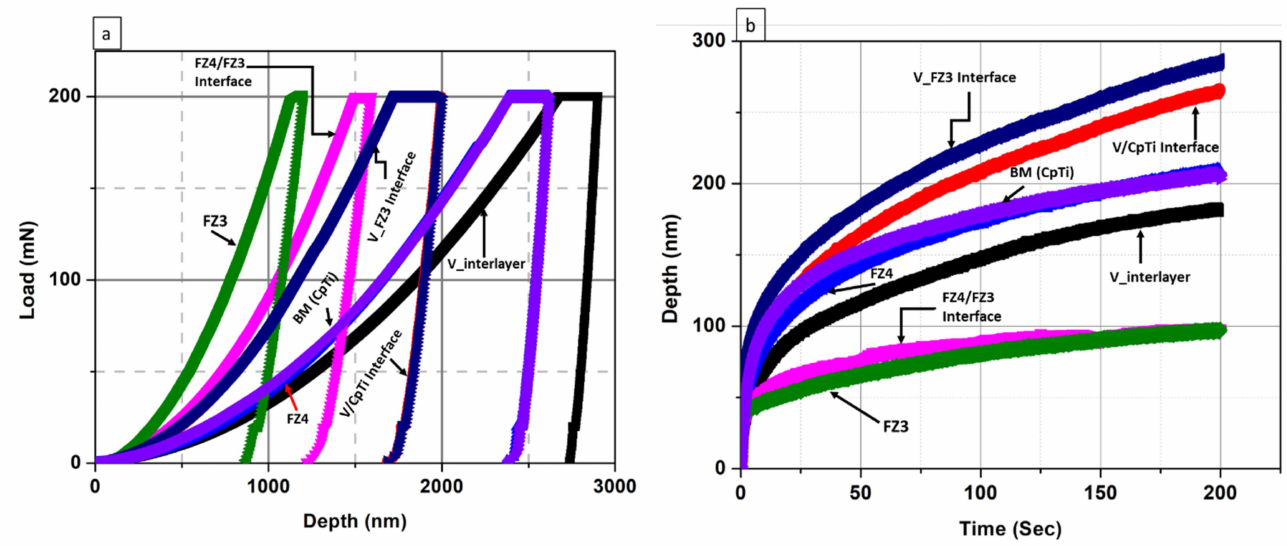
Figure 15. ( a ) The load–displacement (P–h) curves of different weld regions of V and CpTi obtained under 200 mN at 200 sec holding time. ( b ) The displacement–time (h–t) curves obtained in the holding regimes of different regions of V and the CpTi